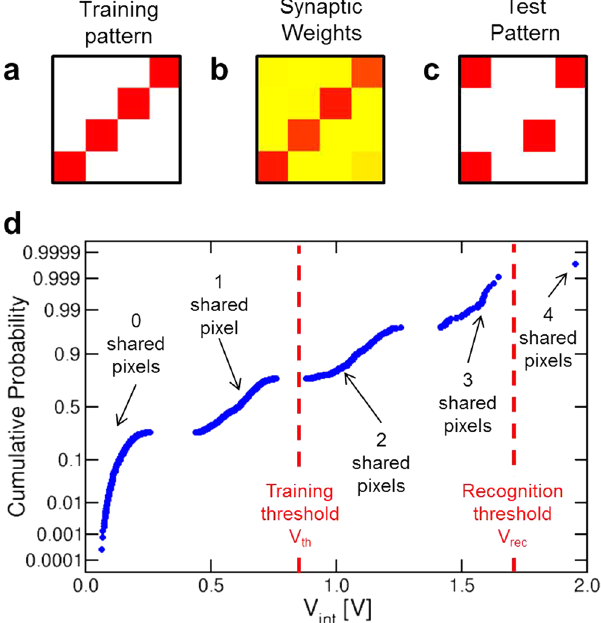
Figure 4. Pattern recognition. ( a,b,c ) The pattern that was submitted during the training phase, the corresponding synaptic weights after 300 training epochs, and one of the possible 1820 test patterns that were submitted during the recognition phase. ( d ) Cumulative distribution of the internal potential values measured after the presentation of the recognition patterns. Each sub-distribution corresponds to a given number of pixels shared with the training pattern. By adopting a threshold voltage V rec = 1.7 V during recognition, only one pattern, i.e ., the training pattern, could trigger fire in the POST, thus preventing any false